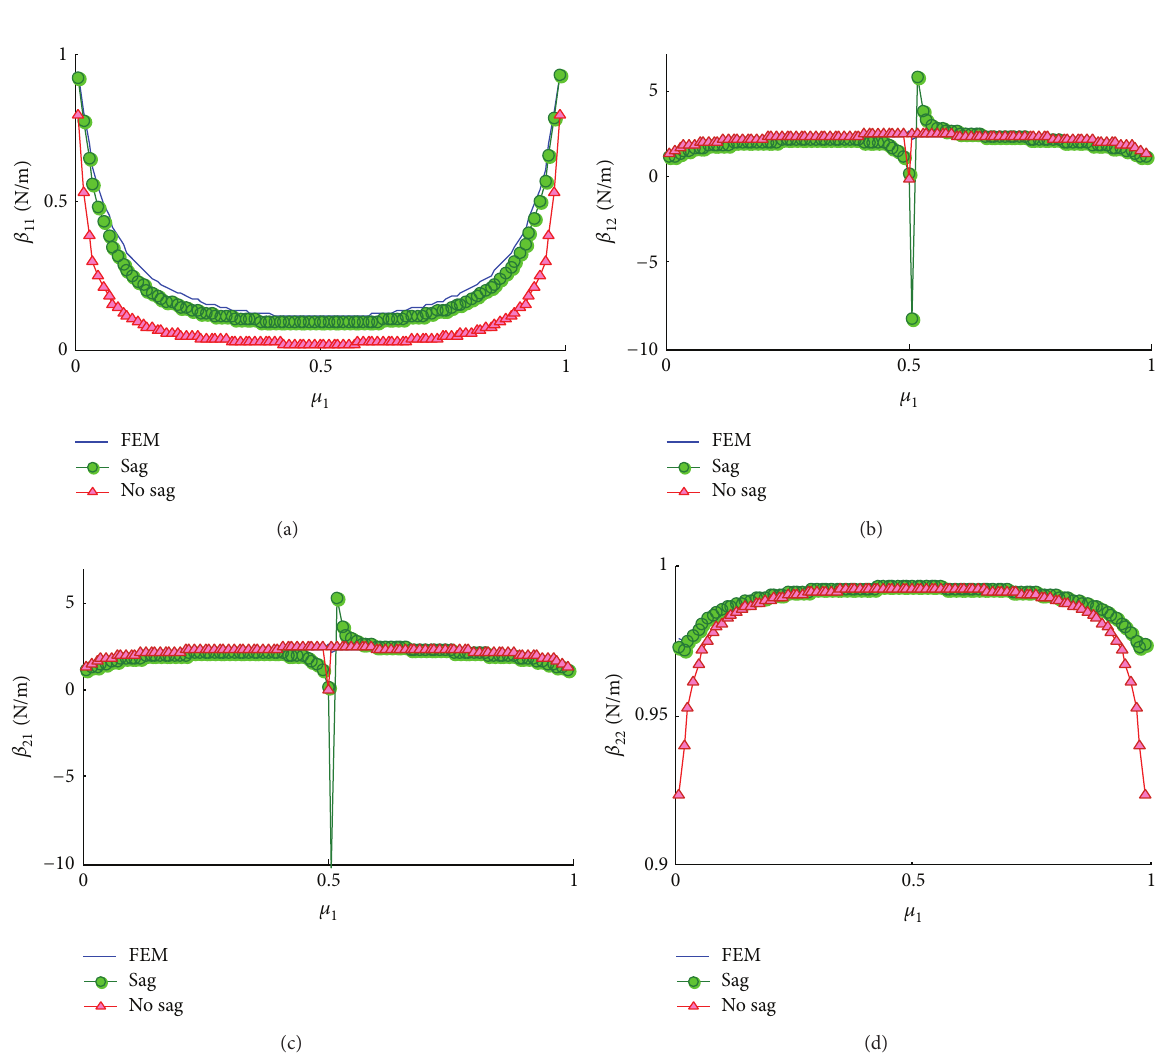
Before analyzing the dynamic stiffness obtained using the three presented methods, the coefficient of dynamic stiffness 𝛽 𝑖𝑗 is defined as